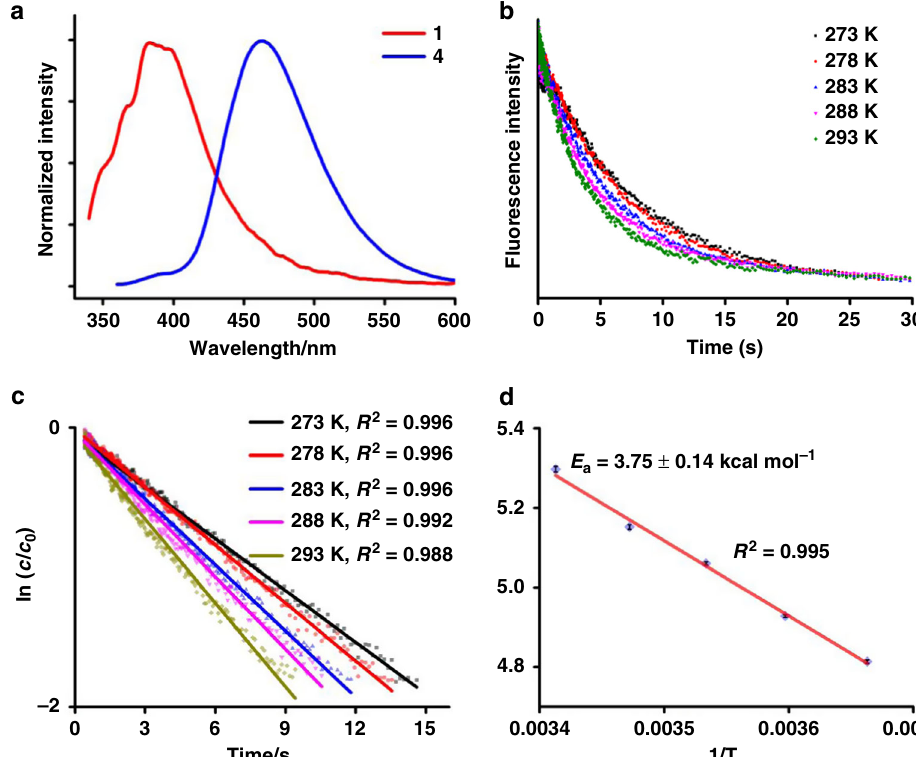
Fig. 6 Kinetic studies on the reaction between 1 and 4. a Emission spectra of 1 and 4 at 298 K (excitation: 330 nm for 1 and 350 nm for 4 , c = 1.0 μ M). b Luminescence (above 495nm) decline curves of the reaction mixture of 1 ( c = 100.0 μ M) and 4 ( c = 1.0 μ M) in chloroform from 273 to 293 K. c Pseudo- fi rst-order fi tting of the luminescence decline curves. d Fitting with the Arrhenius equation from 273 to 293 K, the standard deviation error bars are minor than the